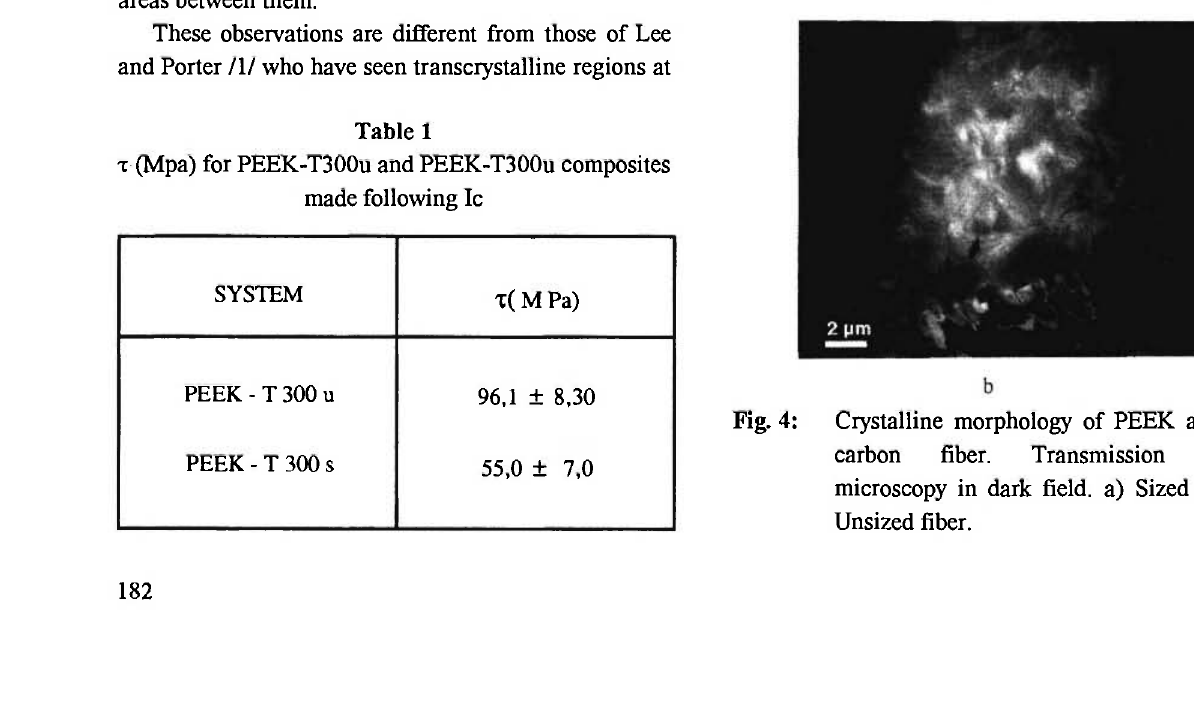
τ (Mpa) for PEEK-T300u and PEEK-T300u composites made following Ic